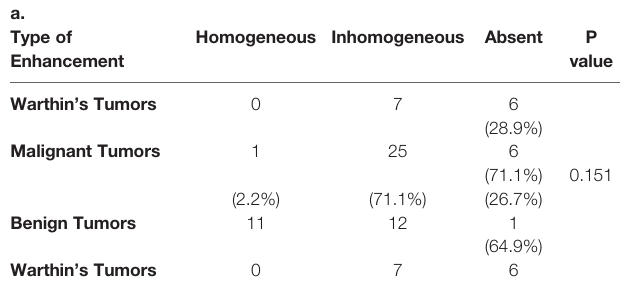
TABLE 5 | Chi-square Test performed on qualitative variables, Type of Margins (a) and Type of Contrast Enhancement (b) in the three patient